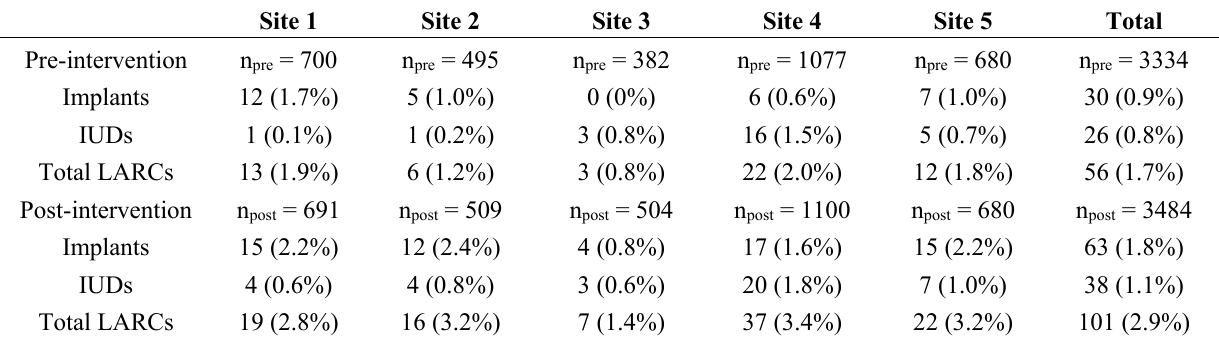
Table 1. Total Number of Implants and IUDs Inserted at Five Public Health